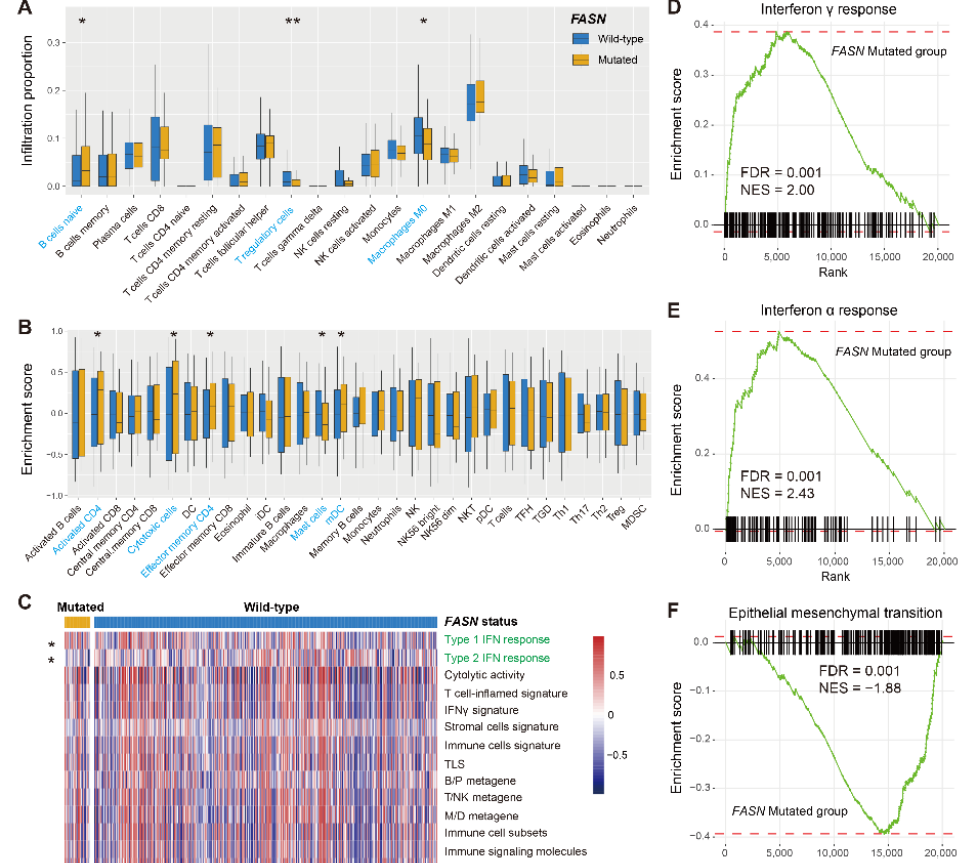
Figure 6. Immune infiltration and pathway enrichment associated with FASN mutations in melanoma. ( A ) Distinct infiltration abundance of 22 immunocytes of FASN mutated and wild-type groups evaluated with the CIBERSORT algorithm. Immunocytes highlighted with blue are significantly differentially infiltrated. ( B ) Distinct infiltration abundance of 31 immunocytes of FASN mutated and wild-type groups evaluated with Angelova et al.’s method. ( C ) Heatmap representation of distinct enrichment scores of 14 collected immune-related signatures in FASN two subgroups. Signatures highlighted with green are significantly differentially enriched. ( D – F ) Significantly enriched